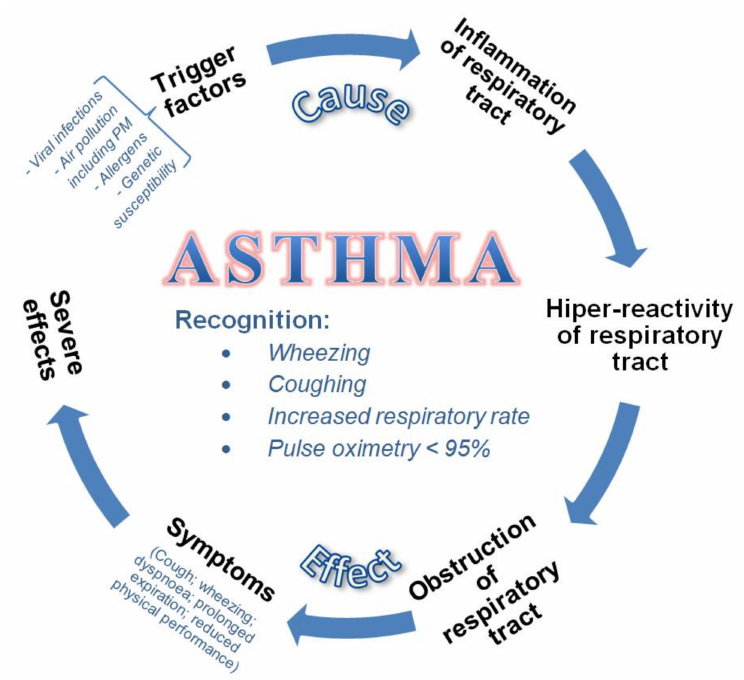
Figure 2. Causal relation between asthma in children and air pollution including airborne fine particulate matter from inflammation of respiratory tract (subclinical effects) to severe effects (Emergency Department visit; hospital admission; status asthmaticus; and premature